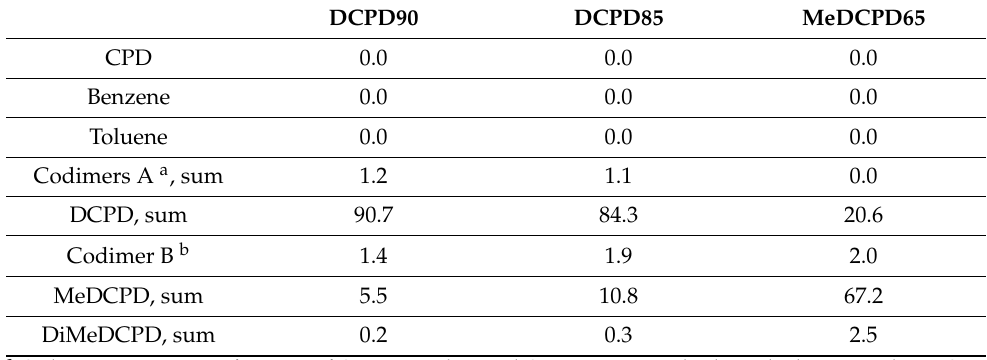
Table 2. Dicyclopentadiene (DCPD) and methyl dicyclopentadiene (MeDCPD) compositions.